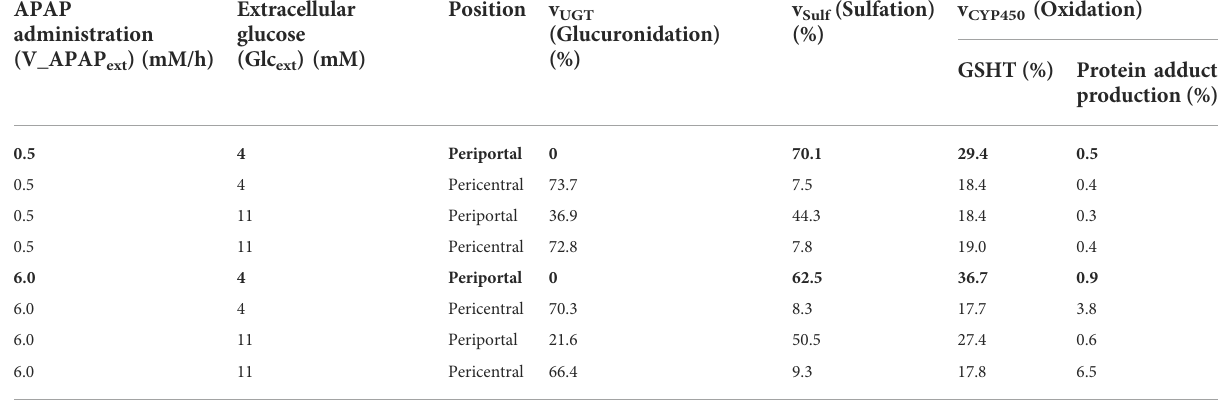
TABLE 2 Relative contribution of APAP metabolic pathways in obese patients.